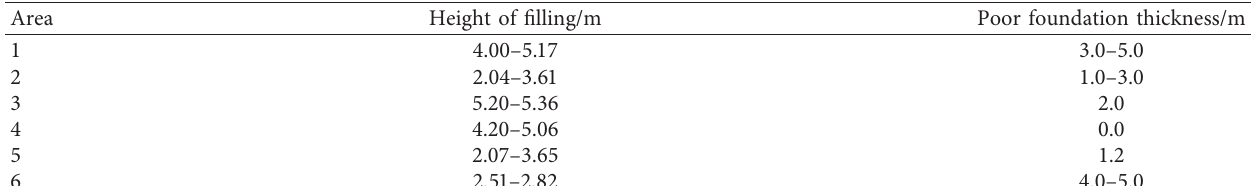
Table 5: Fill height and poor foundation thickness in each testing